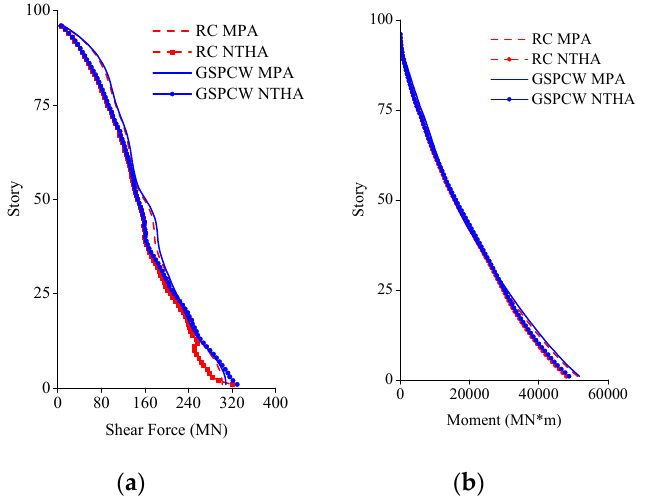
Figure 22. Comparison of story force between the RC and GSPCW models: ( a ) story shear forces; ( b ) story overturning moments.